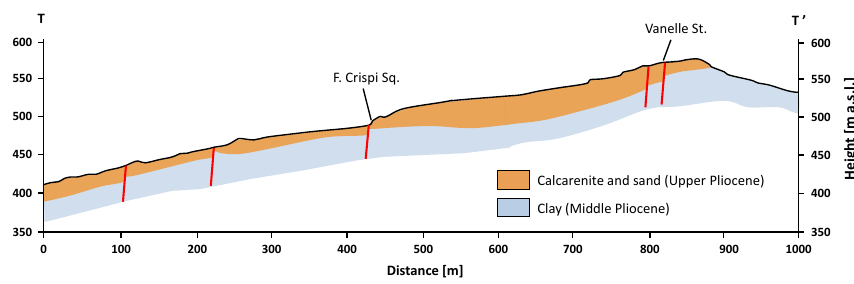
Fig. 15. Simplified cross section T–T’. (Fig. 3), showing the geological (lithological) setting of Naro and the hypothesized distribution of the main surface faults (red lines) derived from recent geological investigations (modified from Basile,